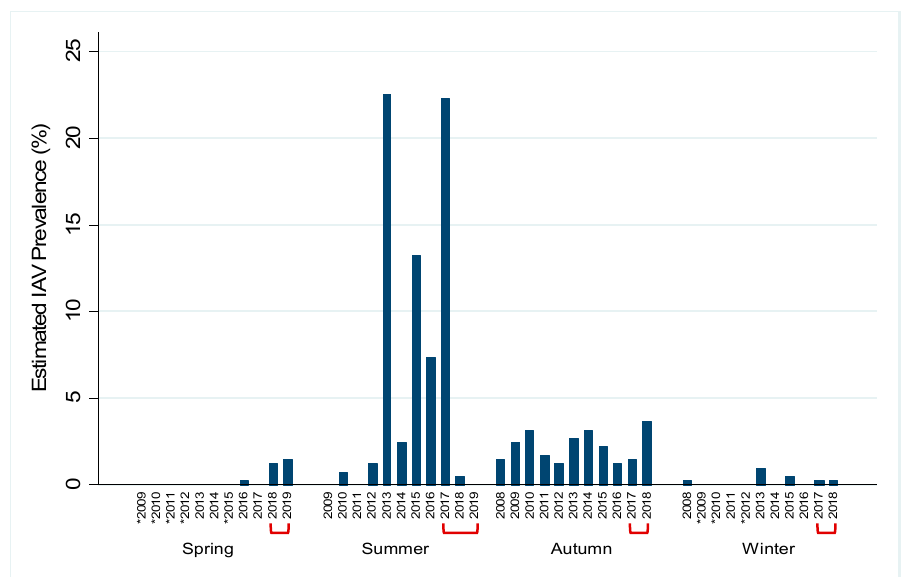
Figure 3. Historical influenza A virus (IAV) surveillance near Port Clinton, Ohio, USA by year and season. Year-round, Active IAV surveillance in wild mallards ( Anas platyrhynchos ) at one location was conducted from July 2017–July 2019 to represent the under-sampled spring season. Historical (autumn 2008–spring 2017) surveillance data for the study location is shown in order to demonstrate the gap in spring surveillance prior to the current study. IAV prevalence for each year by season was estimated by the proportion of IAV isolates and the number of cloacal swabs collected and is shown by the blue bars. Red brackets indicate the current study period. Asterisks (*) represent years for which no samples were collected during that season. Summer: June–August; autumn: September–November; winter: December–February; spring: March–May.